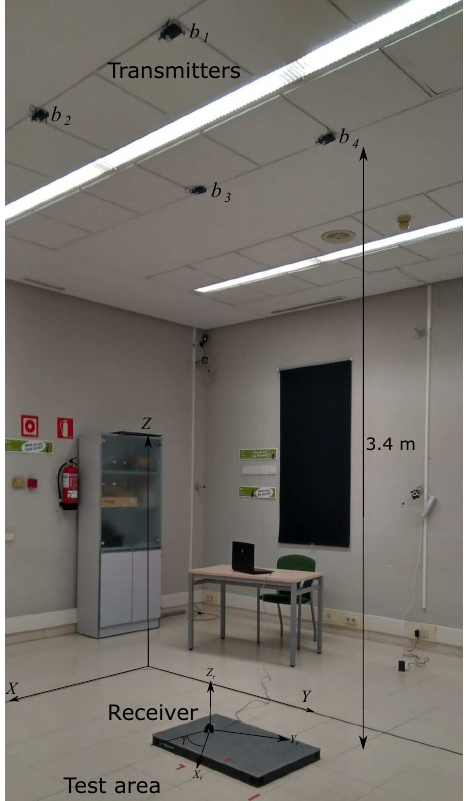
Figure 11. Experimental setup in the proposed scenario.